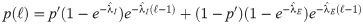
Survival probability as a function of the step length.The survival probability is the percentage of step lengths larger than the corresponding value on the horizontal axis. Each panel depicts the data from the trajectory of one agent picked from (a) aligned swarms and (b) cohesive swarms, so that this figure represents the most frequently observed trajectory for each type of dynamics. The survival distributions of the four candidate models are also plotted. The distributions for each model are obtained considering the maximum likelihood estimation of the corresponding parameters (see Sec. 4.3 for details). The curve for the CCRW model is obtained by an analytic approximation of the probabilities of each step length, given the maximum likelihood estimation of its parameters. Since the order of the sequence of step lengths is not relevant for this plot, we estimate the probabilities of each step length as p(ℓ)=p′(1-e-λ^I)e-λ^I(ℓ-1)+(1-p′)(1-e-λ^E)e-λ^E(ℓ-1) (see Eq (9)) with p′≃11-γII(11-γII+11-γEE)-1.